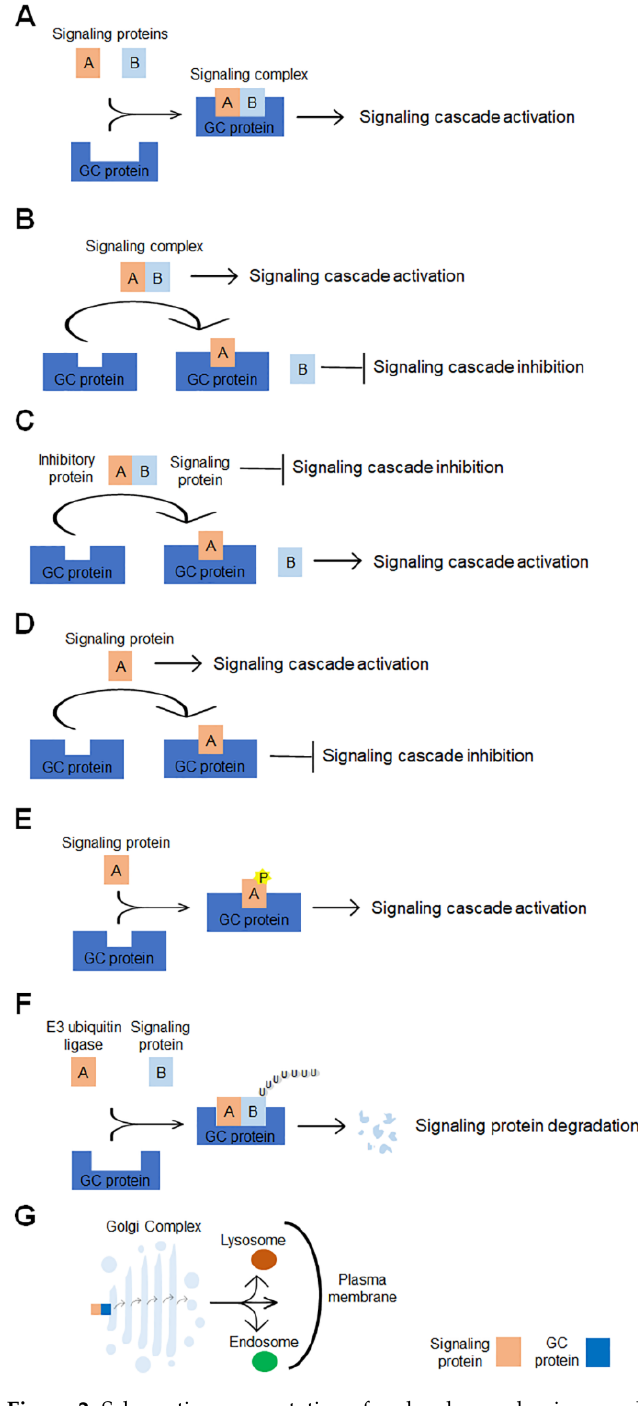
Figure 2. Schematic representation of molecular mechanisms underlying the GC-mediated regulation of signaling pathways involved in tumorigenesis. The GC-localized proteins can modulate the signaling pathways via multiple molecular mechanisms: ( A ) they can promote the complex signaling formation, ( B ) they can disrupt the complex signaling formation, ( C ) they can sequester inhibitory proteins, thus preventing their interaction with signaling molecules, ( D ) they can bind to signaling molecules, thus impairing the signaling cascade activation, ( E ) they can bind to, phosphorylate and activate signaling molecules, ( F ) they can enhance the signaling protein degradation and ( G ) they can promote the signaling molecules processing, intracellular sorting and